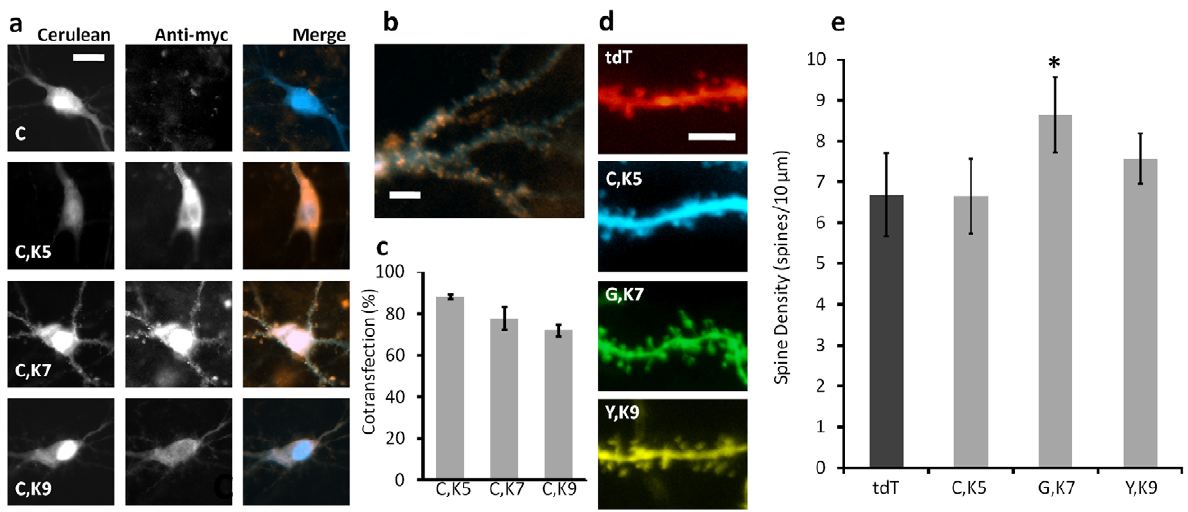
Figure 5. Combinatorial Genetic Transformation of Multiple Single Cells within Brain Tissue and Effects on Spine Densities. (a) Plasmids encoding the three isoforms of Kalirin (Kalirin-5, Kalirin-7, and Kalirin-9) were each co-transfected with pCAG-Cerulean by our system into CA3 pyramidal cells in hippocampal slices. 24 hours following transfection, slices were fixed and stained for the myc tag from the Kalirin isoforms before imaging for Cerulean (cyan) and myc (orange). Scale bar 15 m m. (b)Anti-myc staining in Kalirin-7-transfected cells shows localization into fine points on the dendrites. Scale bar 5 m m. (c) Co-transformation efficiencies determined by co-staining for pCAG-Cerulean and the three pEAK-His-Myc- Kalirin vectors, were 88.2 6 2.2% ( n =24), 77.1 6 11.1% ( n =21), and 71.9 6 5.5% ( n =20) for Kalirin-5, Kalirin-7, and Kalirin-9, respectively. (d) A series of transfection cycles were carried out on CA3 pyramidal cells in the same slice (8 total slices) to analyze the effects of exogenous expression of the three Kalirin isoforms on linear dendritic spine density of basal dendrites. Cells were transfected with either tdTomato (tdT) as a control, Cerulean and Kalirin-5 (C,K5), EGFP and Kalirin-7 (G, K7), or YFP and Kalirin-9 (Y, K9). Spines were imaged 24 hours post-transfection. Scale bar is 10 m m. (e) Linear spine densities for four groups: tdT cells had an average of 6.7 6 1.0 spines/10 m m ( n =95 segments from 19 cells). C,K5 exhibited no statistically higher spine density (6.65 6 2.0 spines/10 m m, n =60 segments from 11 cells, p=0.74) and so Y,K9 (7.6 6 0.6 spines/10 m m n =55 segments from 9 cells, p=0.08). G,K7, however, did show a statistically higher linear spine density (*) compared to tdT (8.6 6 0.9 spines/10 m m, n =75 segments from 15 cells, p , 10 2 4 ).